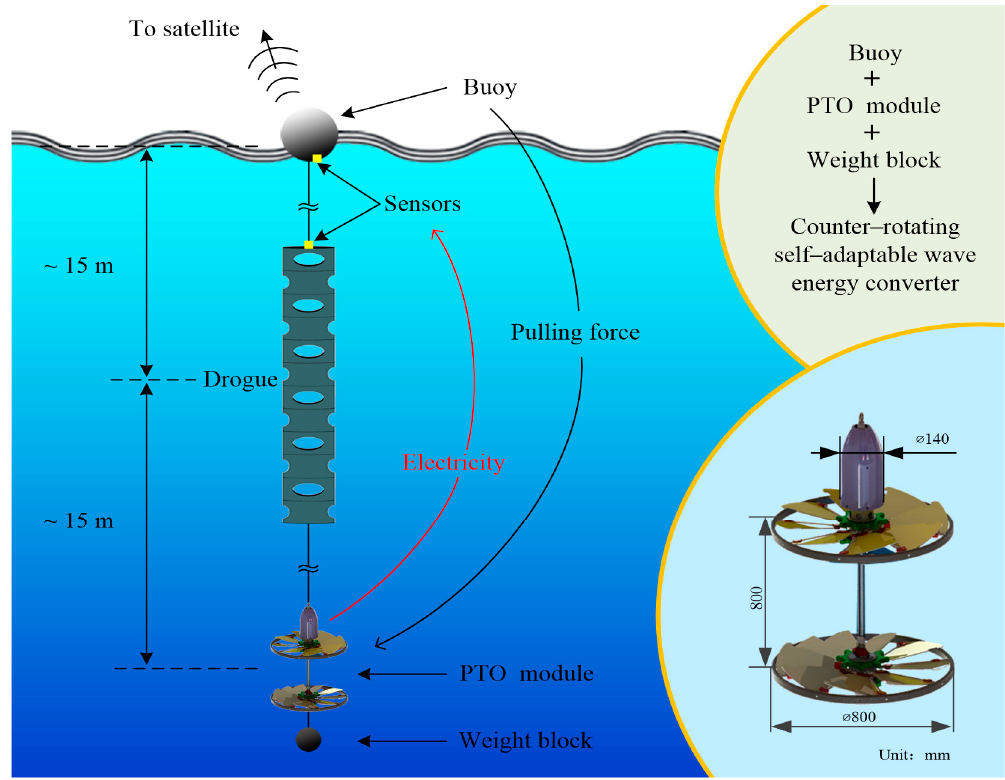
Figure 3. Wave energy-powered SVP drifter concept with a counter-rotating self-adaptable WEC.